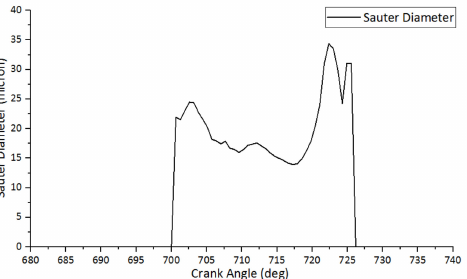
Figure 7. Sauter Mean Diameter (SMD) of fuel spray